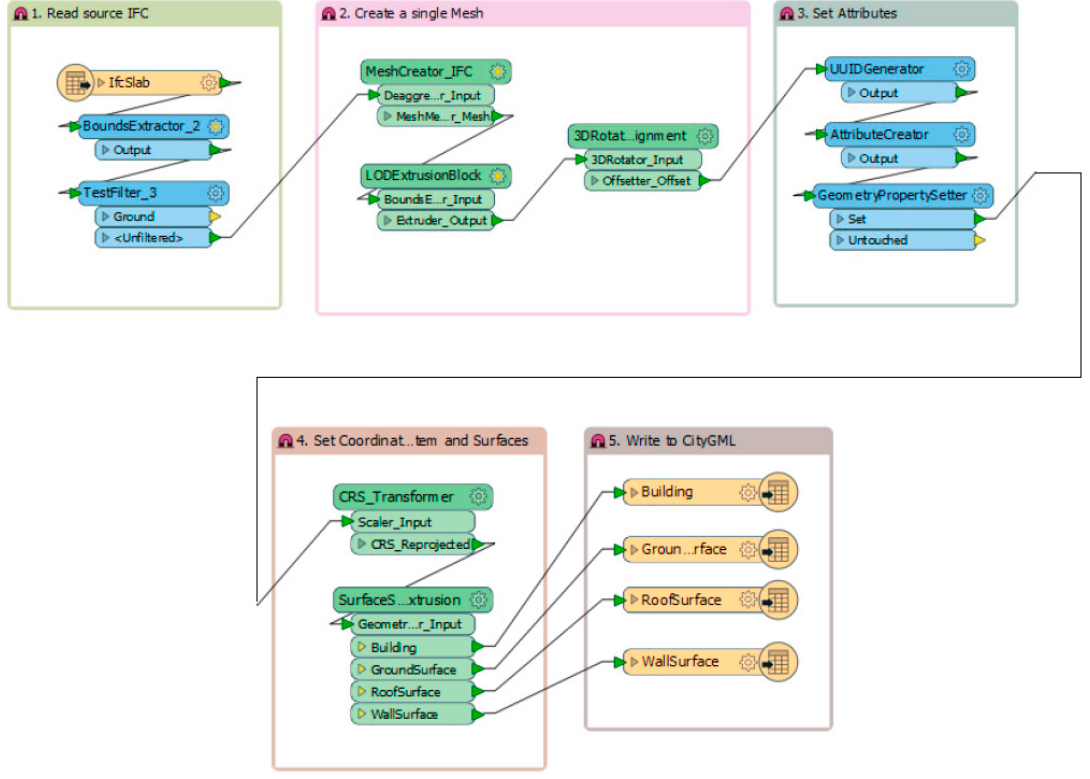
Figure 4. IFC to CityGML LOD 2 transformation workflow.